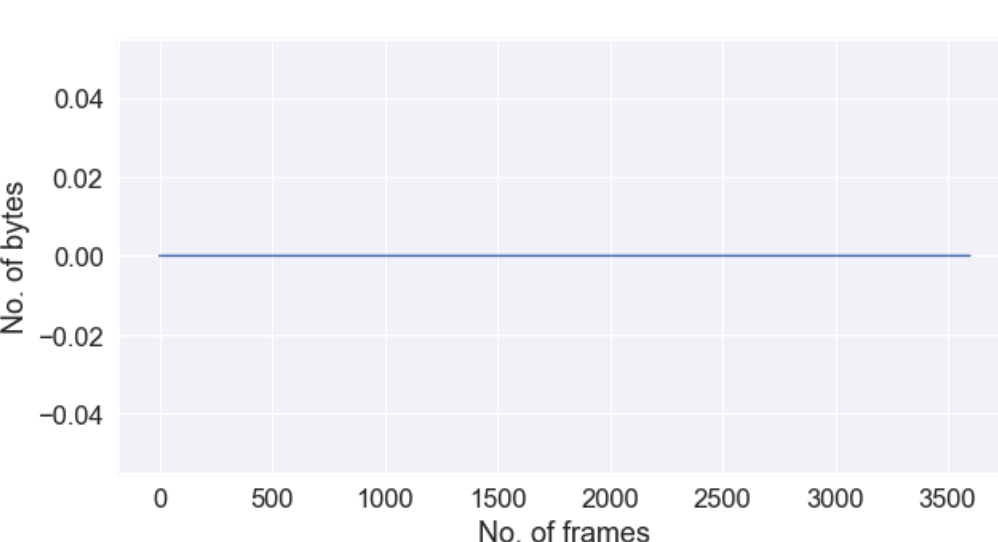
Figure 15b. Network bytes sent in S2.1.